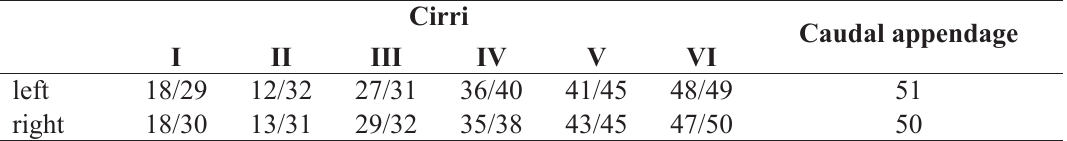
Table 1. Number of segments on cirri I–VI and caudal appendage of the holotype of